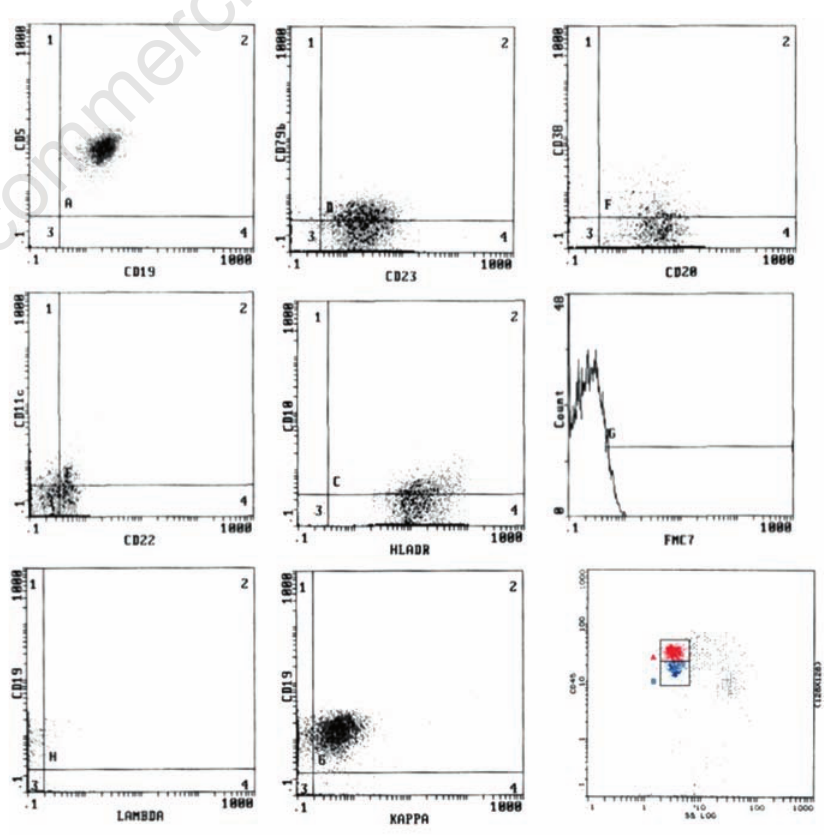
Figure 1. Flow cytometric analysis of a case of chronic lymphocytic leukemia